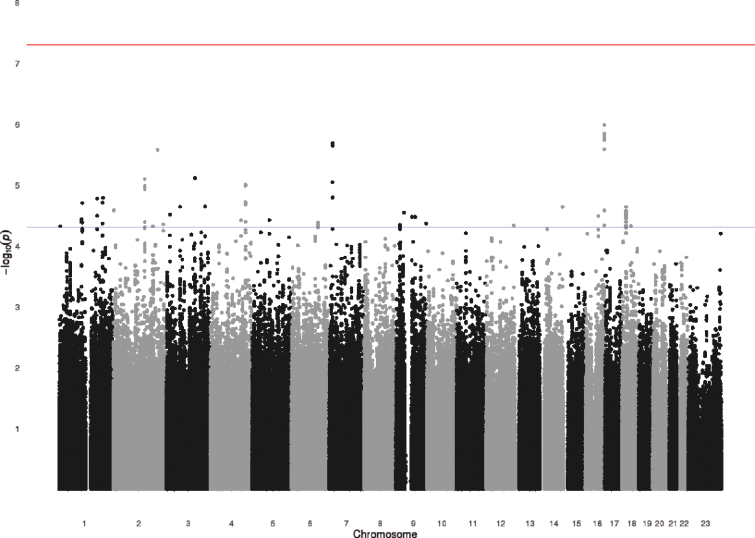
Manhattan plot for the genome-wide association studies of definite psychotic experiences at ages 12 or 18. The Y-axis shows –Log (P values) of the logistic regression analysis (additive genetic model) for single nucleotide polymorphisms tested with definite psychotic experiences at ages 12 or 18 compared to none at both time points.